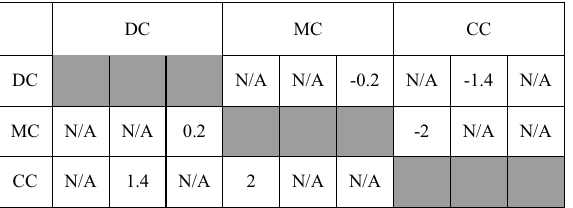
Table 4. Pairwise comparisons of clusters. *DC: designer cluster; MC: manufacturer cluster; CC: customer